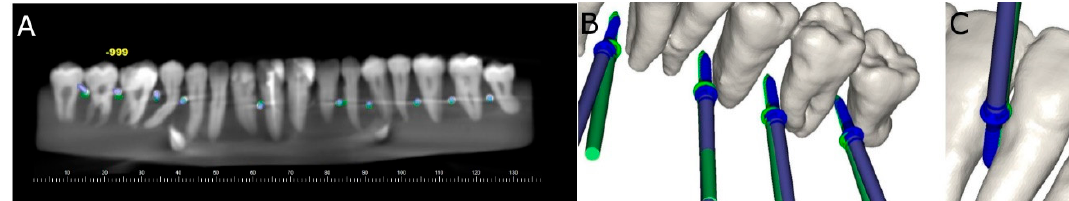
Figure 3. ( A ) Radiographic analysis of the root perforation in the 3D implant planning software, ( B ) relationship between the root processes and the planned (green micro-screw) and performed (blue micro-screw) orthodontic micro-screws using the computer-aided static navigation technique and ( C ) by the conventional freehand technique.